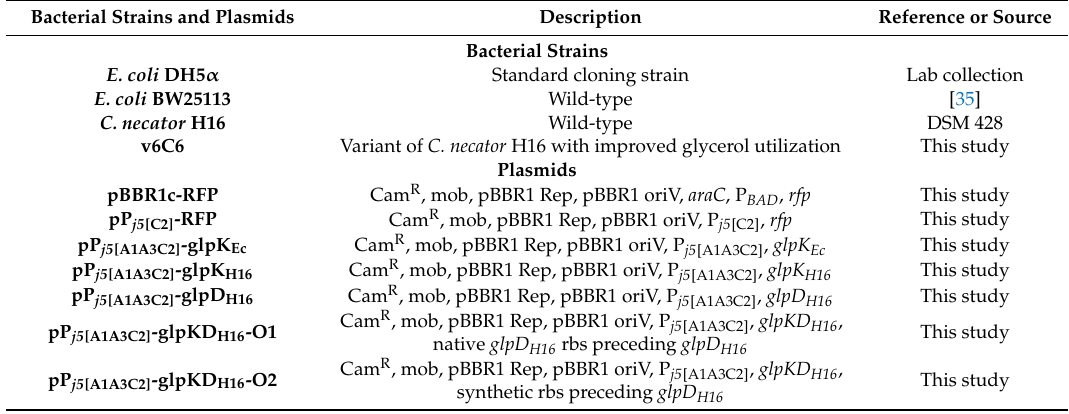
Table 4. Bacterial strains and plasmids used in this